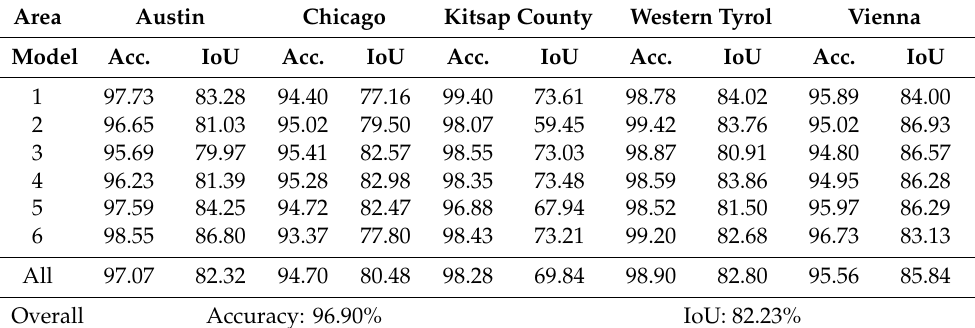
Table 3. Summary evaluation results for all six models by area and overall. Area